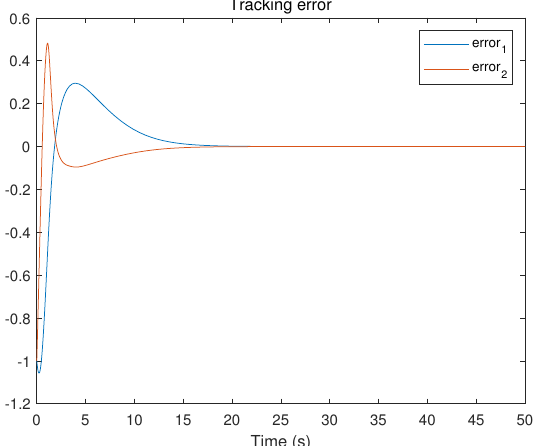
Figure 14. Tracking error trajectories when η 1 = − 0.2 and η 2 =